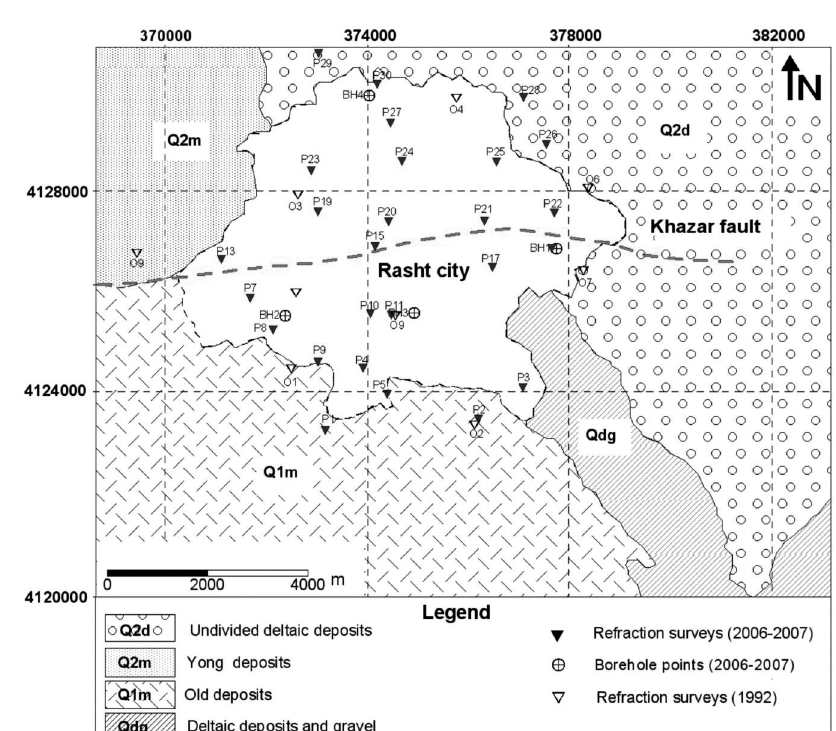
Fig. 3. Distribution of seismic profiles throughout the Rasht